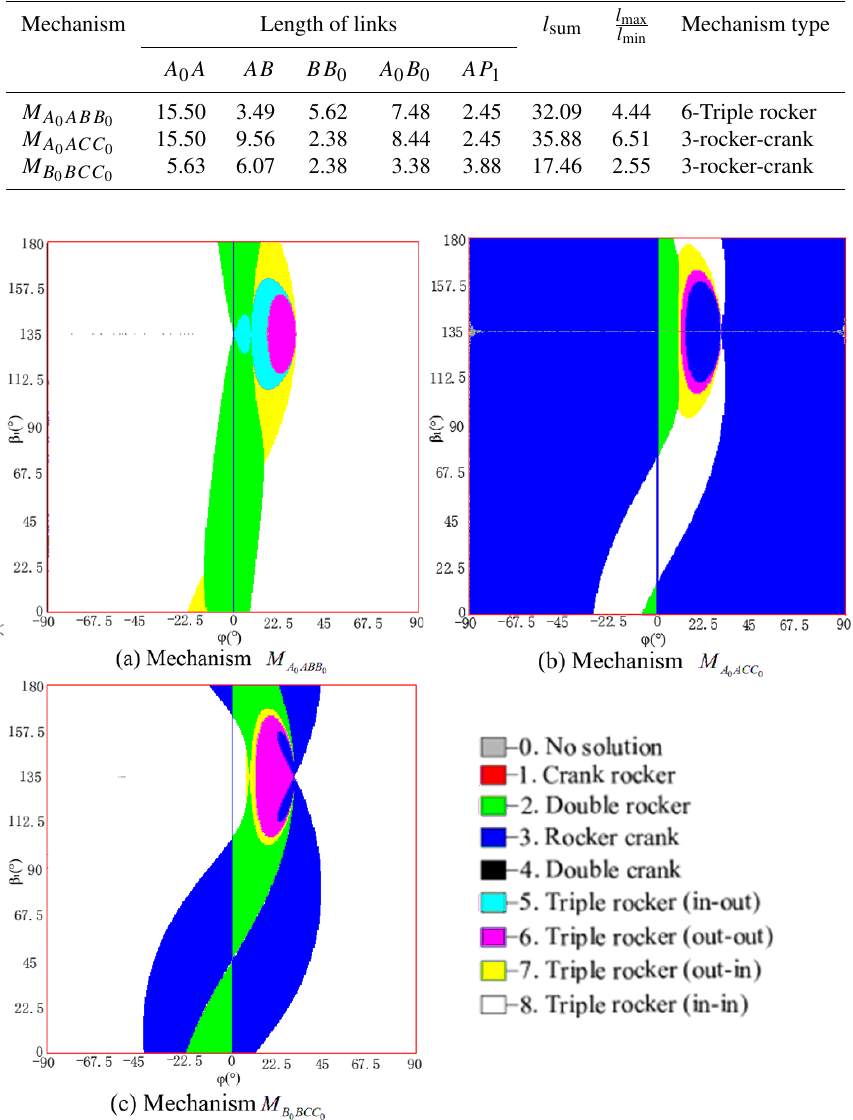
Figure 4. Mechanism solution region diagrams for all mechanism